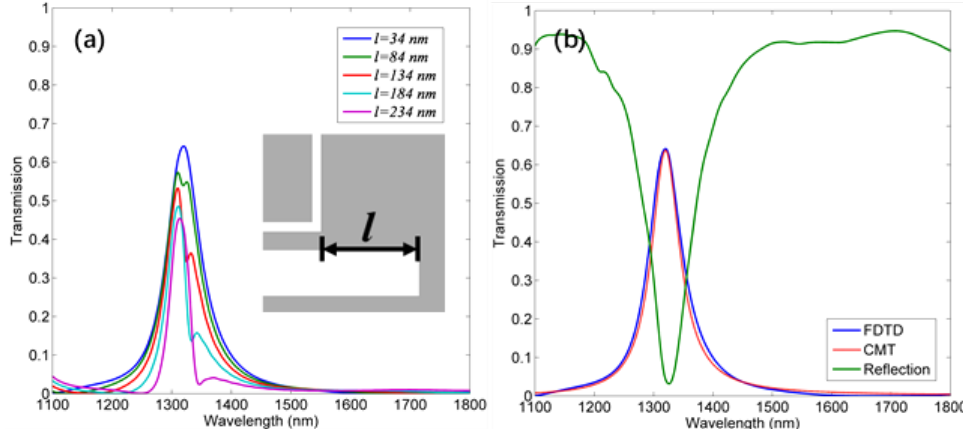
Figure 3. ( a ) The drop spectrum corresponding to different values of l . The inset is the reflector structure. ( b ) The drop spectrum with a reflector from FDTD and CMT, and the reflection spectrum when l = 34 nm.